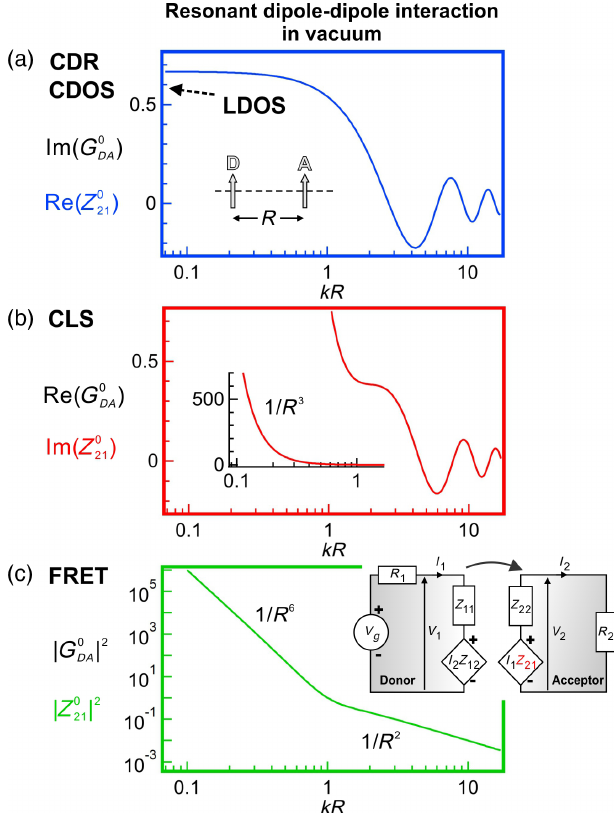
FIG. 1. Complex-valued Green function in vacuum describing the RDDI versus the dipole-dipole separation R . (a) Imaginary part of the Green function, which is related to the cooperative decay rate (CDR) and cross density of states (CDOS). It converges to the LDOS as R → 0 . The inset describes the dipoles ’ mutual orientations considered here. (b) Real part of the Green function, which determines the cooperative Lamb shift (CLS). In contrast to the imaginary part, the real part of the Green function diverges as R → 0 . (c) Square modulus of the Green function, which is linked to the energy transfer FRET. G 0 projection of the Green tensor on the dipole direction in homogeneous space which is related to the mutual impedance Z 0 21 between the two dipoles. The inset, showing the two-port network model of dipole-dipole interaction, illustrates how the mutual impedance may be